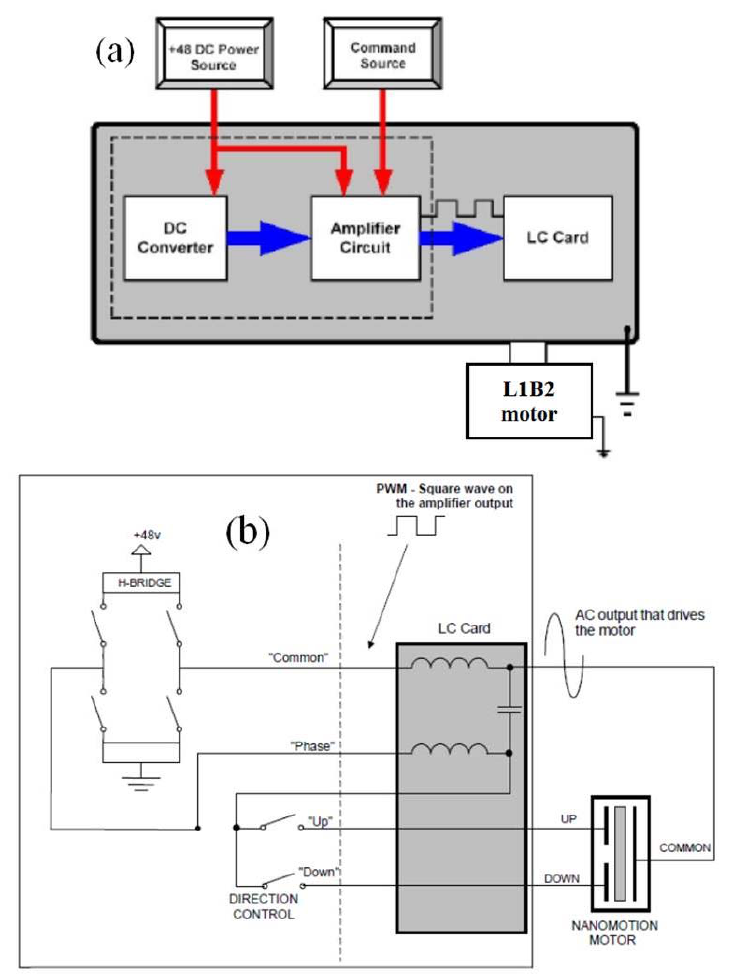
Figure 3. Schematic representation of an ultrasonic motor driver design (Nanomotion AB1A driver [15]): ( a ) Main driver stages; ( b ) Diagram of the output stage with an internal LC card (single channel with a direction switch).